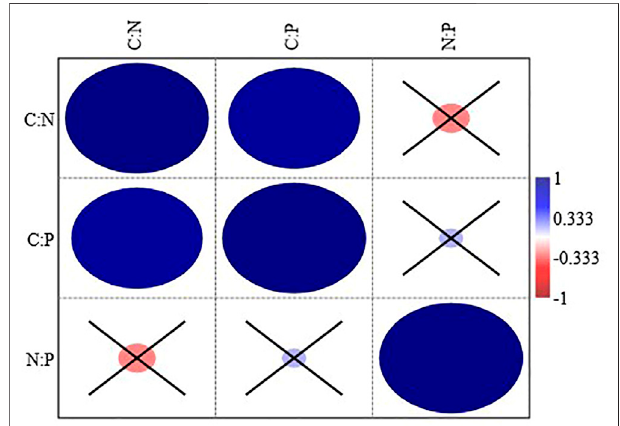
FIGURE5| PearsoncorrelationbetweenthecharacteristicsoflitterCNP stoichiometry among all the forest types and litterfall components. Forests: CTF, camphor tree forest; MPF, Masson pine forest; CMF, camphor tree and Masson pine mixed forest. Litter components: leaf litter, branch litter, and miscellaneous litter. Pearson correlation is signi fi cant at p < 0.05; all the non-signi fi cant values are shown with a cross symbol.